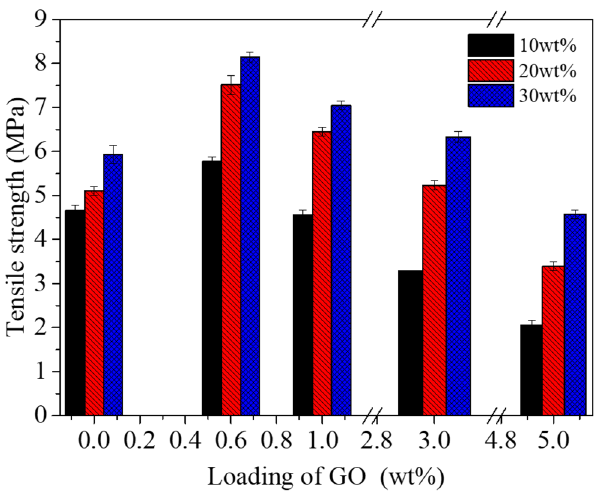
Figure 9. Tensile strength of GO-TPU films with different loadings of GO and TPU initial concentrations of 10 wt %, 20 wt %, and 30 wt %, respectively. Error bars in the plots are standard error.